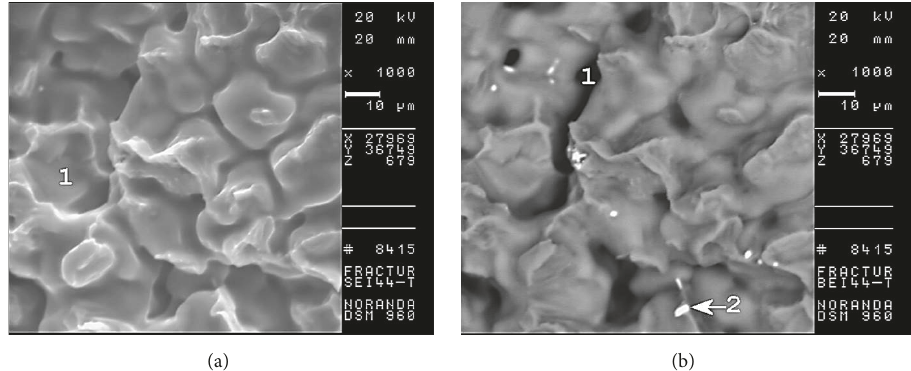
Figure 7: (a) Secondary electron image of the A alloy, 4 wt% Al; (b) backscattered electron image of